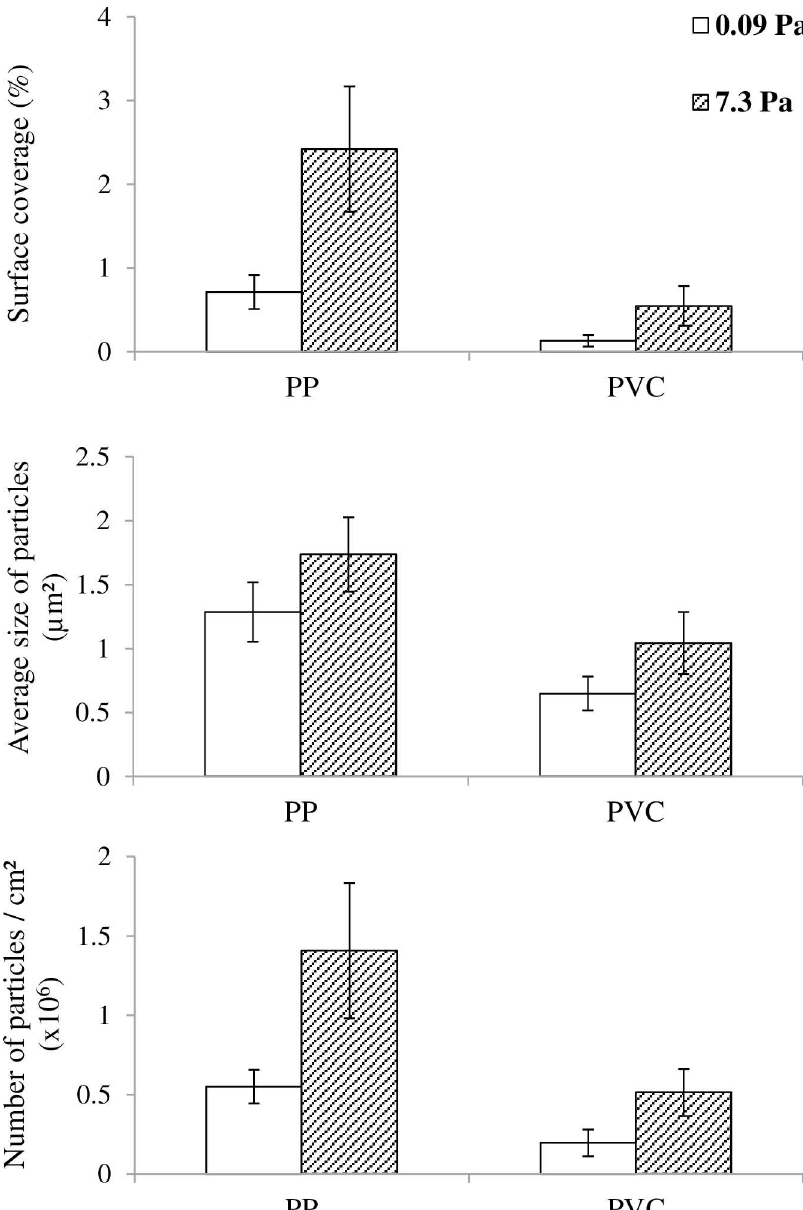
Fig 4. Results of the morphological characterization for Phase 3, material test. Bar plots representing the surface coverage(A), the averagesize of particlesin μ m 2 (B) and the numberof particlesper cm 2 (C) obtained for both materialsPP and PVC (Mat experiment). Empty bars are for low wall shear stress (0.09 Pa) and hatchedbars are for high wall shear stress (7.3 Pa). As mentioned in Table 2, two slides of PP and two slides of PVC were characterized per reactor. Standardvariations are represented.They were calculated from the gatheringof the 120 pictures recordedfrom the two